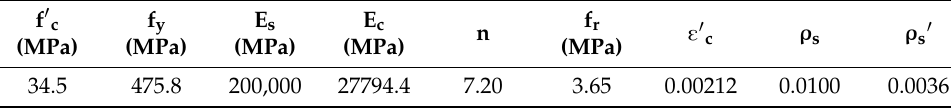
Table 5. The material parameters for Decker (2007) beam.